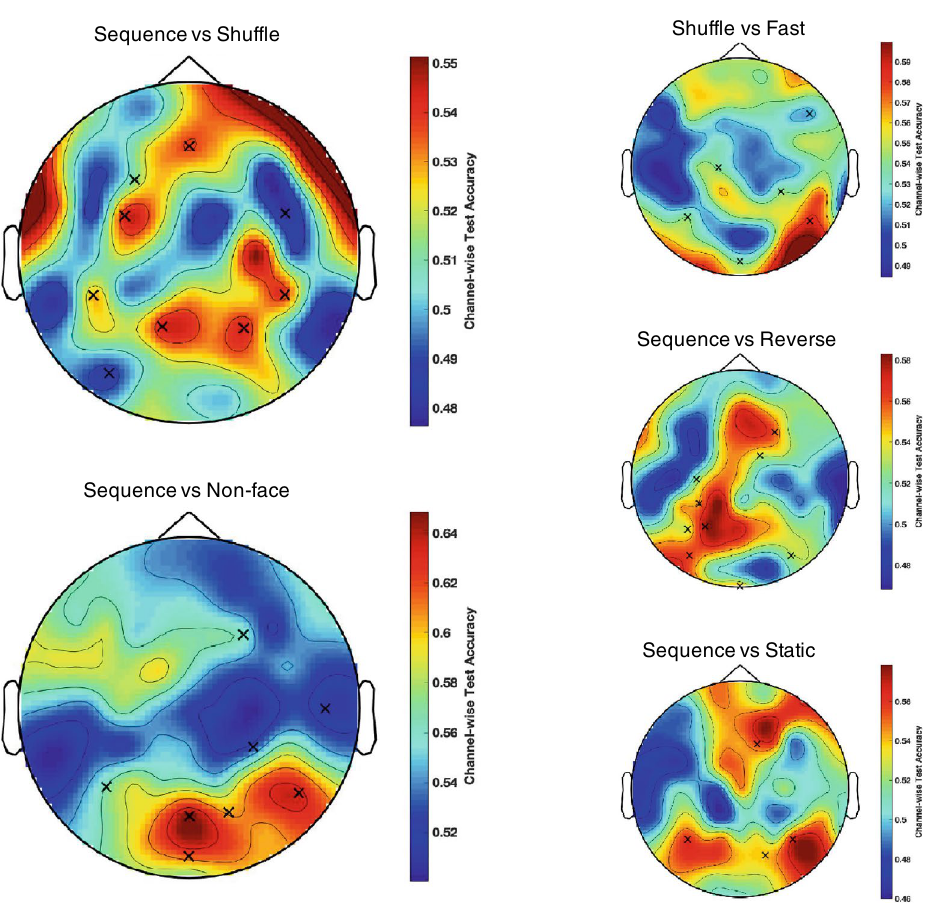
Figure 2. Topographical maps for the comparisons in Table 2 are presented. These maps show the classification accuracies at each channel alone when the selected frequencies in the IM spectrum are used. For instance, in the case of the comparison sequence versus non-face, the selected frequencies are 1.5, 3, 4.5, 19.5, 10.5, 9, 13.5 Hz whereas the selected channels are POz, P8, F4, P5, CP4, Oz, PO4, T8 which are also indicated as black crosses in the map